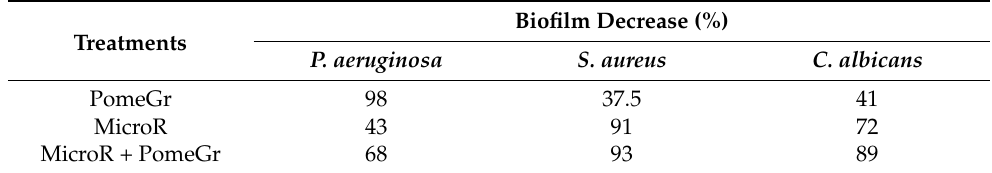
Table 1. Percent of microbial biofilm decrease upon exposure to PomeGr and/or MicroR.